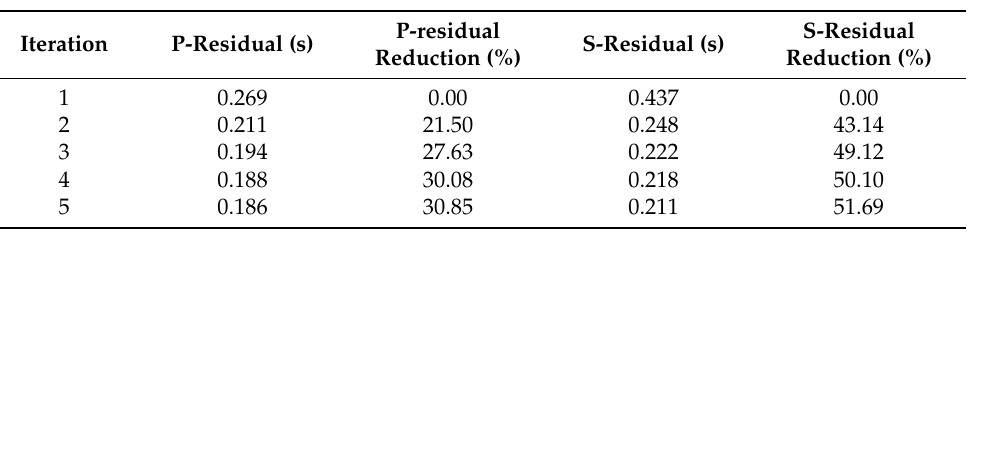
Table 2. Average absolute values of P- and S-wave residuals and their cumulative reduction percent- age during the inversion of experimental